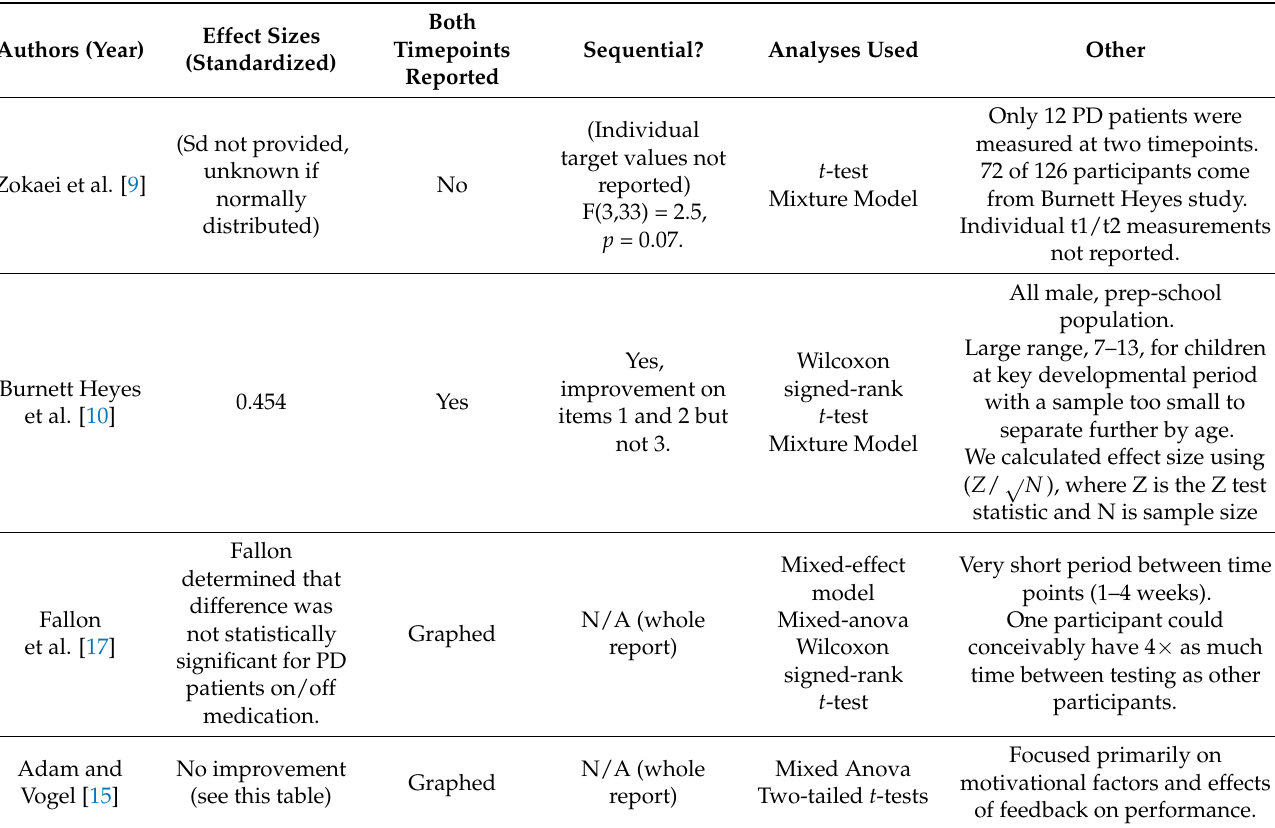
Table 4. Summary of the analytical components of the four